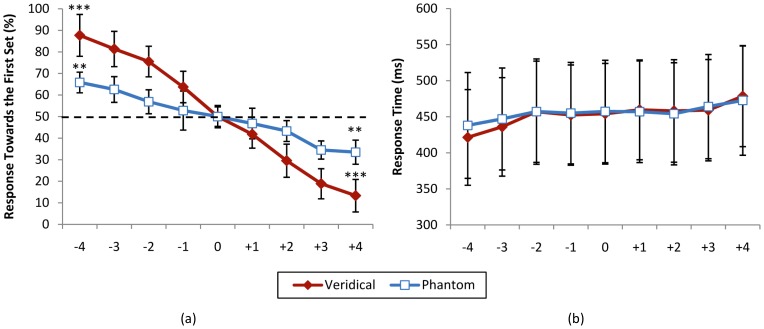
Psychometric function for the duration judgement task.(a) Percentage response towards the first set and (b) response time for veridical (t1≠t2, n1 = n2) and phantom (t1 = t2, n1≠n2) conditions. Horizontal axis shows different levels of comparison (t2−t1 for veridical and n2−n1 for phantom trials). *** p<0.001, ** p<0.005. Error bars reflect one standard deviation.